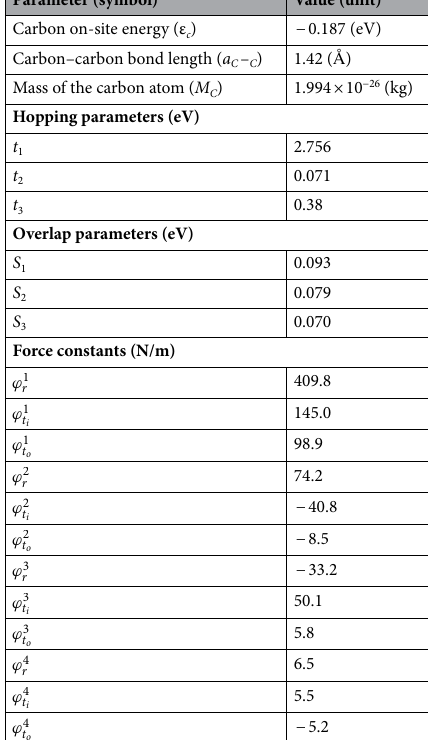
zigzag edge geometries. The numbers on the left and the bottom of the device section are for easy identification of those vacancies. Three examples of how to identify vacancies are shown. Vacancies are identified with the general form of VT-m-n-or, in which the VT is the vacancy type, here it can be SV or DV, m and n are atomic positions in the armchair and zigzag directions, respectively, and the last part indicates respective orientation to the nanoribbon axis. For single vacancies, it is omitted, but for divacancies, the relative orientation of the hypothetical line between two removed atoms determines the last part. If a DV is perpendicular to the ribbon axis (or parallel to the ribbon width), it is indicated with ‘pr’, it is indicated with ‘or’. To be more precise, the cyan box in Fig. 1 indicates a divacancy DV-7–8-or, in which its first atom (as numbers, from left to right) is in the seventh atomic position in the armchair direction, and the eighth atomic position in the zigzag direction, this divacancy is oriented respect to the ribbon axis which is indicated by “or” in the name of the DV. The direction, in which vacancies move in the structure is marked by the green arrow. The dashed lines are bonds that are affected throughout the study. The hatched area shows the zone where the vacancies are introduced. To employ the NEGF method for electronic and phononic contributions, matrices that describe electron and phonon energies and their interaction with nth nearest neighbors, are essential. To form matrices for electrons (i.e., Hamiltonians) in the tight-binding approach, the unit cell should be defined (as depicted in Fig. 1 with dashed gray rectangles). In the non-orthogonal tight-binding approach, the Hamiltonian of the system, its ele- ments, and the elements of overlap matrix are as 7 :